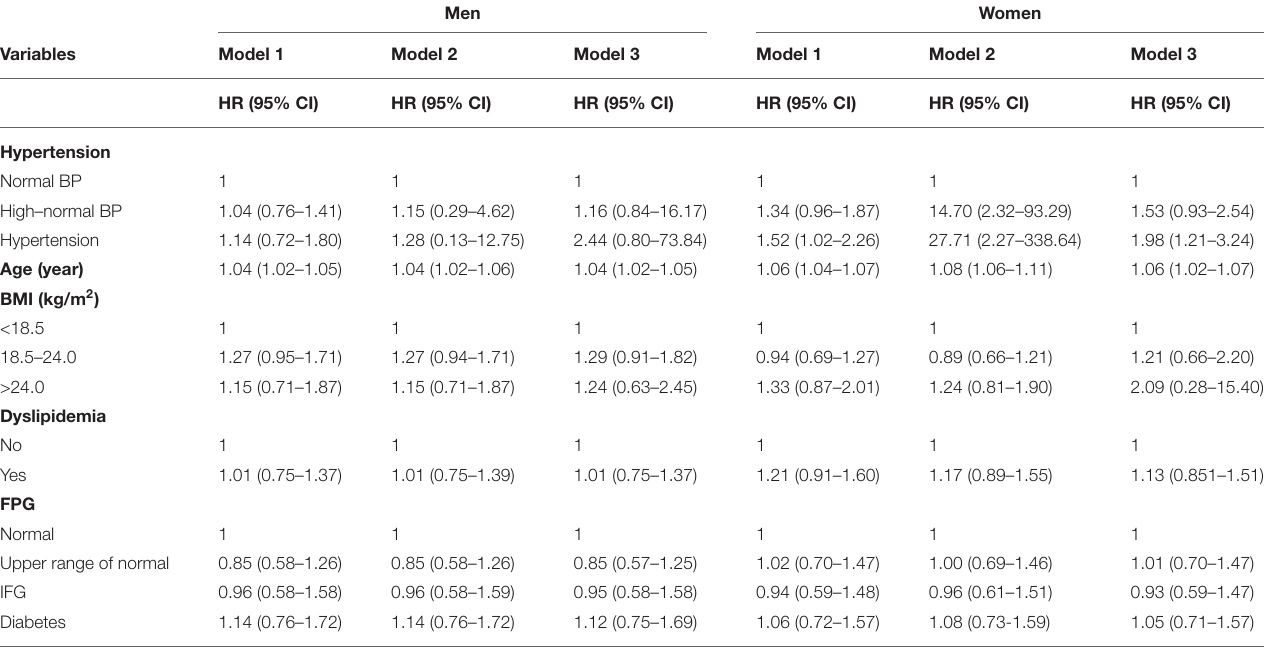
TABLE 4 | Analysis of variables that may affect the association between BP (normal, high-normal, and hypertension) and risk of carotid